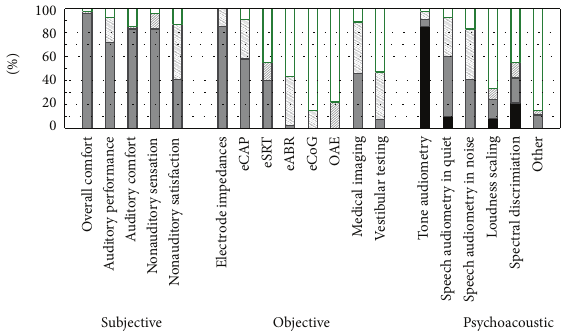
Figure 5: It shows the different outcome assessments which were enquired in the questionnaire together with the frequencies of the responses. The outcomes are grouped into 3 groups (subjective, objective, and psychoacoustic outcomes). The possible answers were (1)yesweassessthisanduseittooptimizethefitting(solidblackand grey bars), (2) yes we assess this but for other reasons than steering the fitting, like for documentation or longitudinal followup (shaded bars), or (3) no we do not use to assess this (white bars). For the solid bars (assess and use it) a distinction was made into whether they have well defined targets to reach (black) or not (grey).